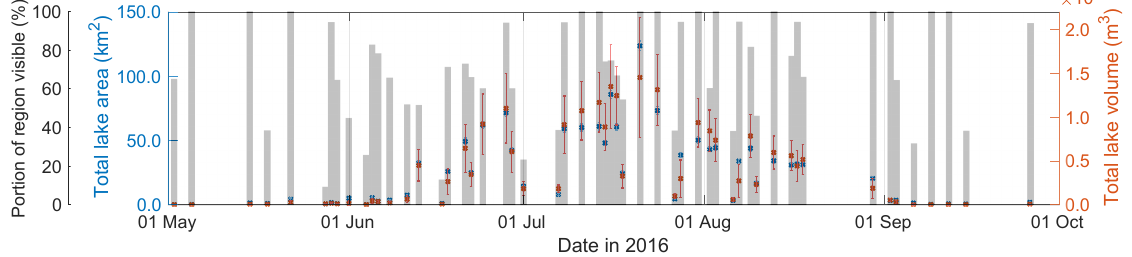
Figure 6. Evolution to total lake area and volume across the whole study region during the 2016 melt season. “Portion of region visible” measures the percentage of all of the pixels within the entire region that are visible in the satellite image, i.e. which are not obscured either by cloud (or cloud shadows) or are not missing data values. Figure 7 presents total lake area and volume after normalising for the proportion of region visible. Blue error bars for lake area were calculated by multiplying the lake area RMSE of 0.007km 2 (Sect. 2.3) by the number of lakes identified on each image; red error bars for total lake volume were calculated by multiplying the lake depth RMSE of 0.555m (Sect. 3.1) by the pixel size and the number of pixels identified as water covered in each